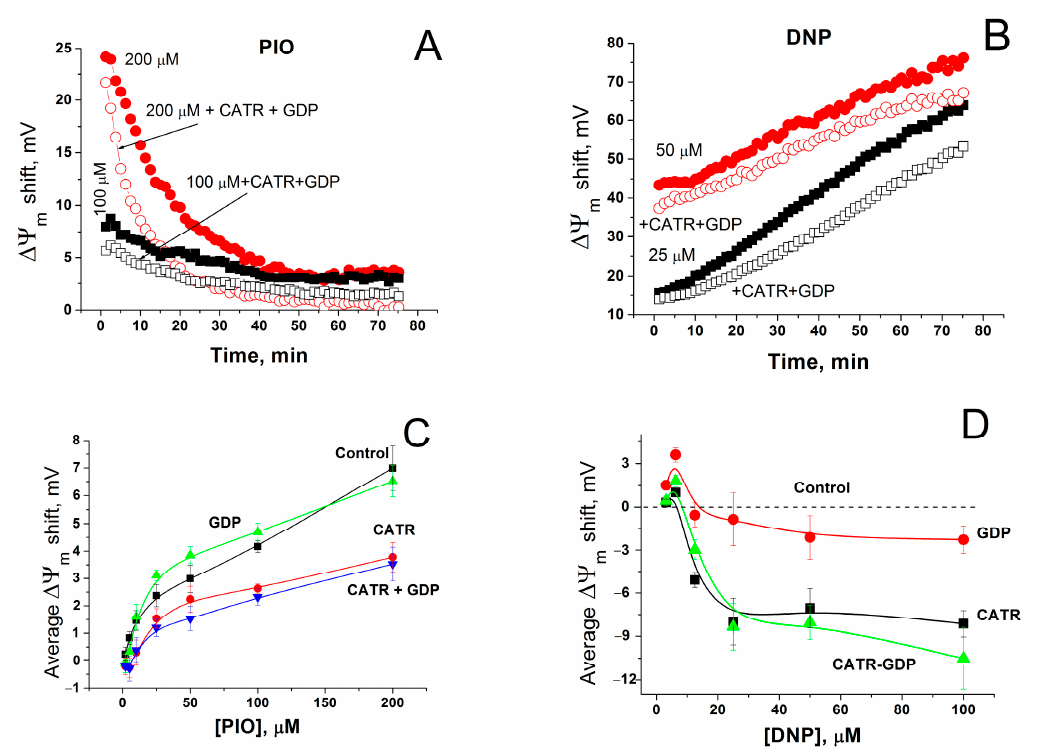
Figure 5. Effect of inhibitors of ANT and UCPs on the shift in ΔΨ m caused by PIO and DNP. Incubation medium contained indicated concentrations of PIO and DNP, and, where shown, 1 mM GDP and 2 µM CATR. ( A , B ) Dynamics of ΔΨ m changes (decrease) in relation to control (1% DMSO). The data of one representative experiment of three similar